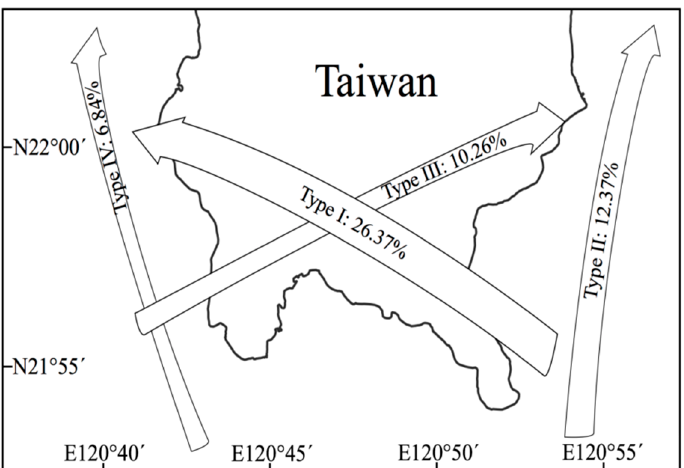
Figure 4. Common trajectories that typhoons took through southern Taiwan between 1911 and 2018. Type I and III indicate a typhoon running north-westwards and north-eastwards, respectively. The other two indicate a typhoon running northwards along the east (type II) and west coasts (type IV). The data were collected from the Typhoon Database, Central Weather Bureau, Taiwan.